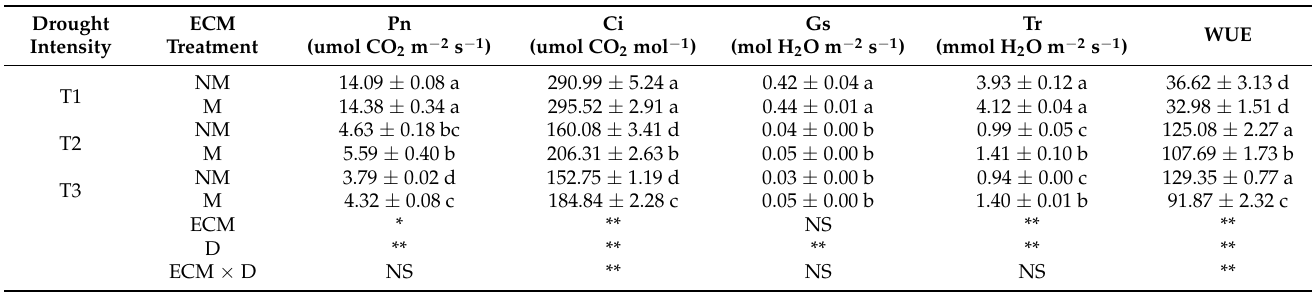
Values (means ± SEs) followed by different letters among treatments indicate significant differences at the 5% level; NS, not significant * p < 0.05; ** p < 0.01. D means drought treatment. Pn, net photosynthetic rate; Tr, transpiration rate; Ci, intercellular CO 2 concentration; Gs, stomatal conductance; WUE, leaf water use